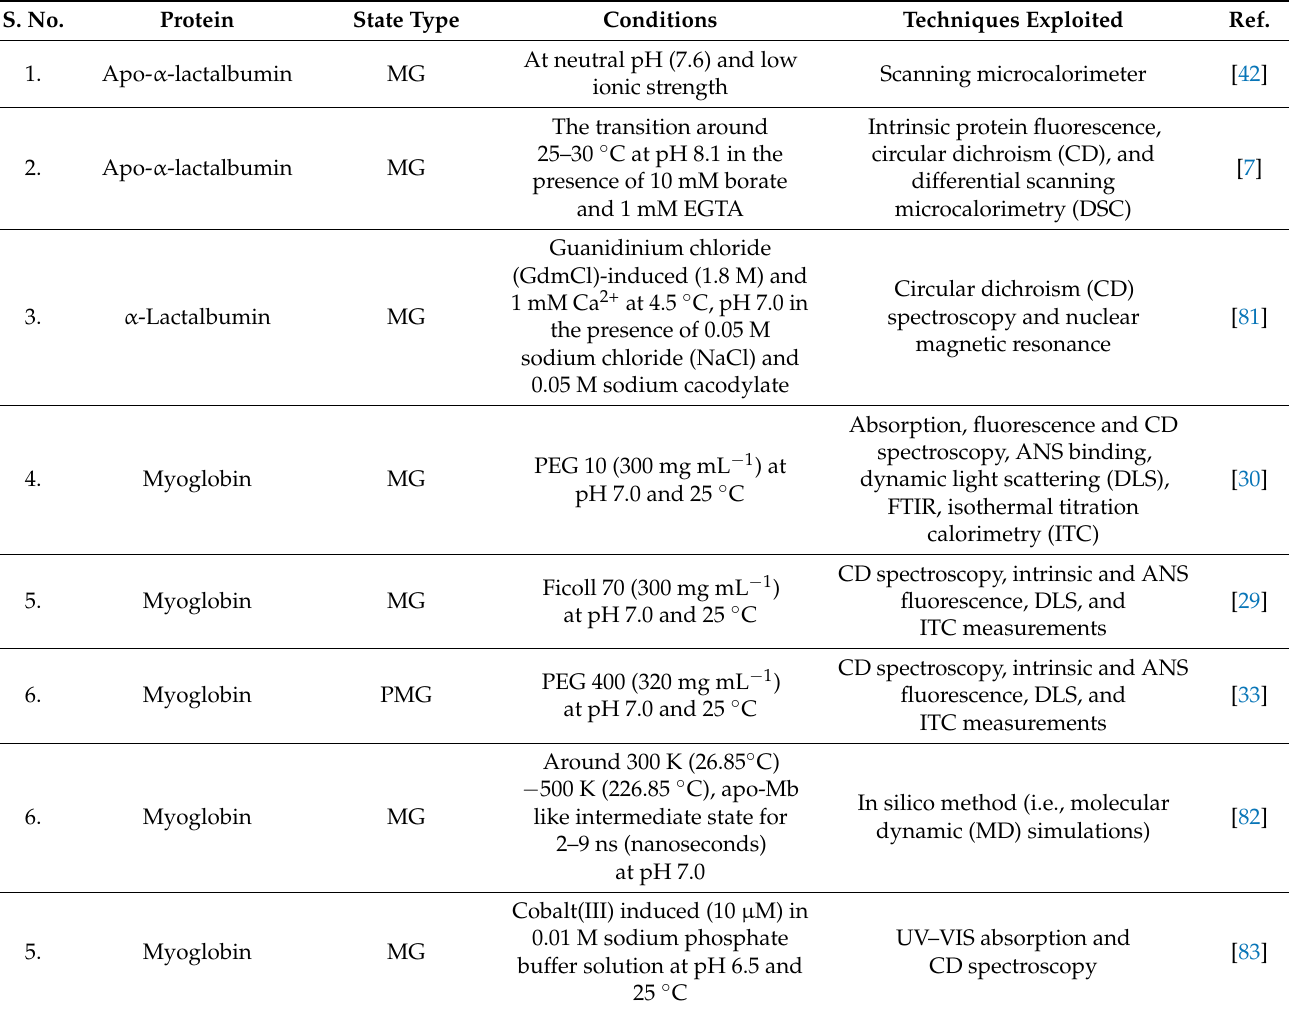
Table 1. List of various intermediate states of proteins characterized under in vitro conditions using various